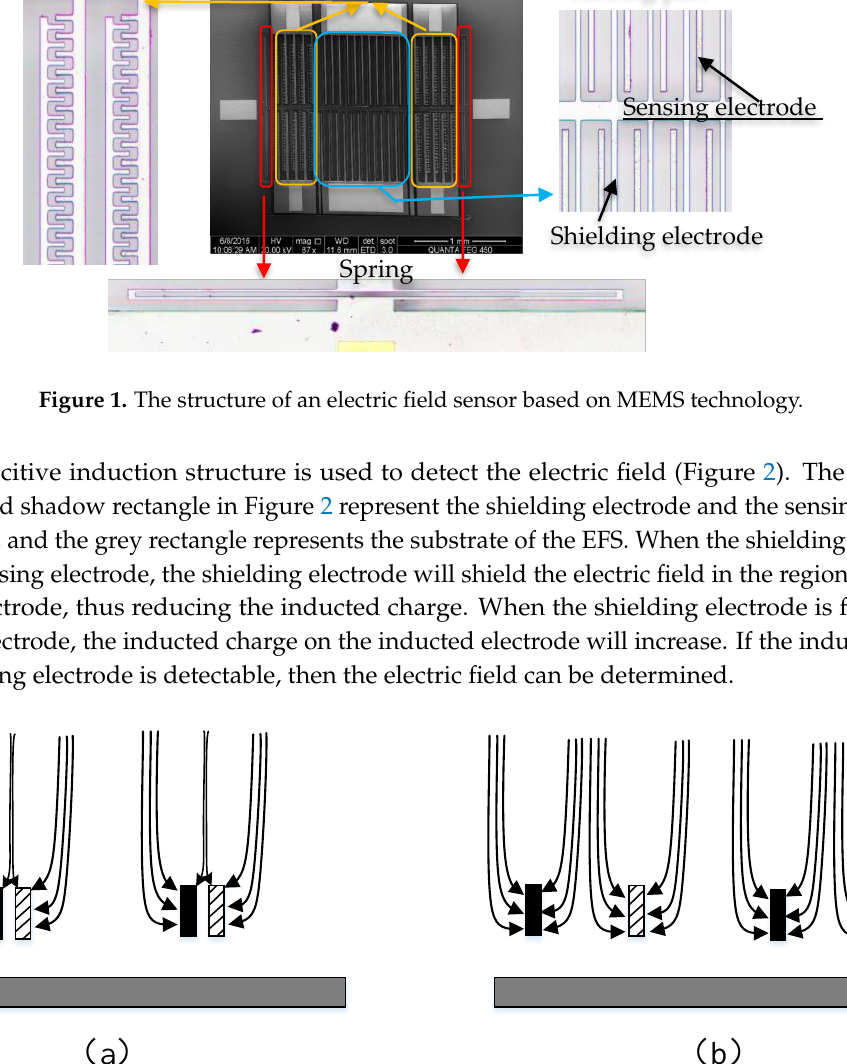
Figure 2. Schematic of electric field shielding: ( a ) shows the situation in which the shielding electrode is near the sensing electrode, and ( b ) shows the situation in which the shielding electrode is far from the sensing electrode.